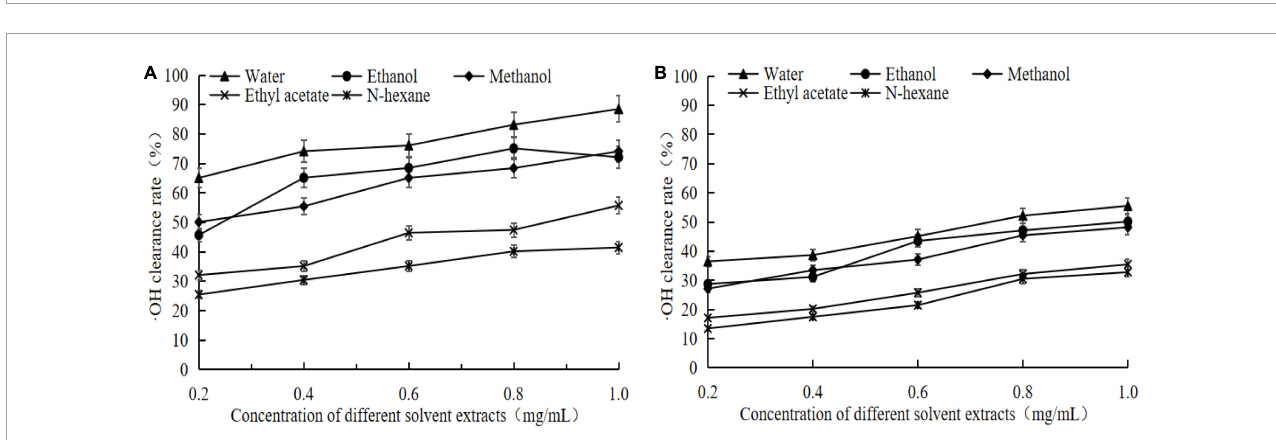
FIGURE4 · OH clearance of extracts from germinated adzuki bean and adzuki bean. Panel (A) is the OH scavenging rate of different solvent extracts of germinated adzuki bean, and panel (B) is the OH scavenging rate of different solvent extracts of adzuki